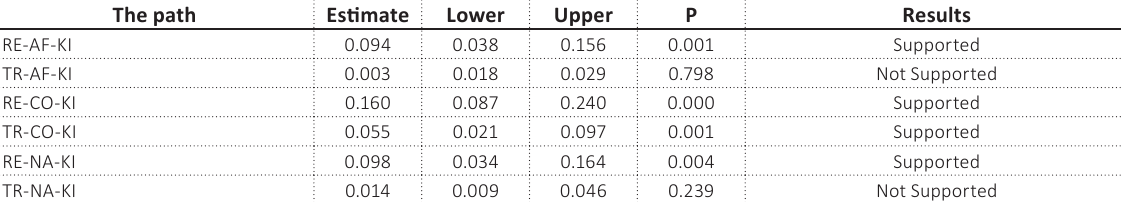
Table 9. Mediating effect